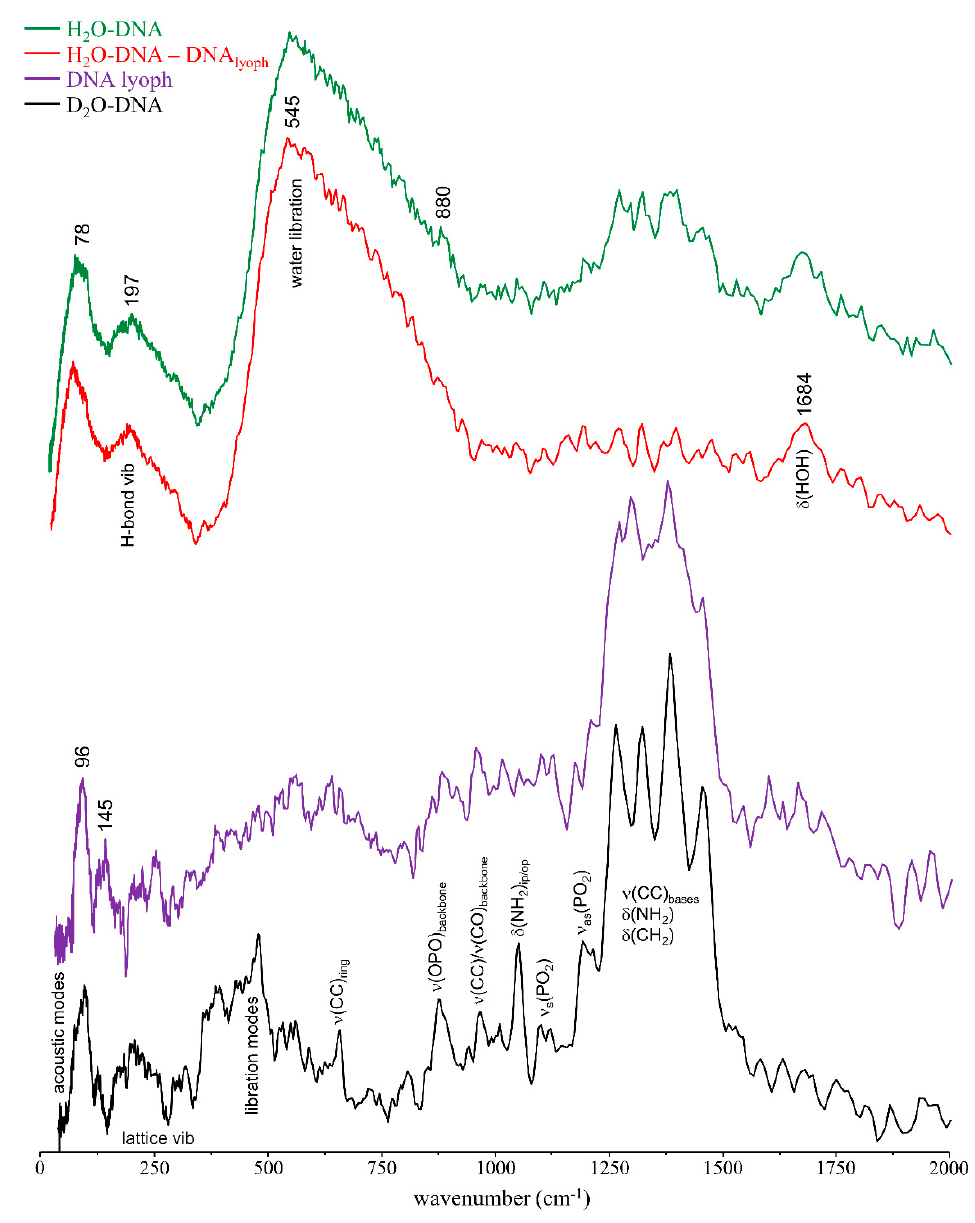
Figure 3. INS spectra (at 10 K) of DNA lyoph , D 2 O-DNA hyd , H 2 O-DNA hyd and (H 2 O-DNA hyd –DNA lyoph ).